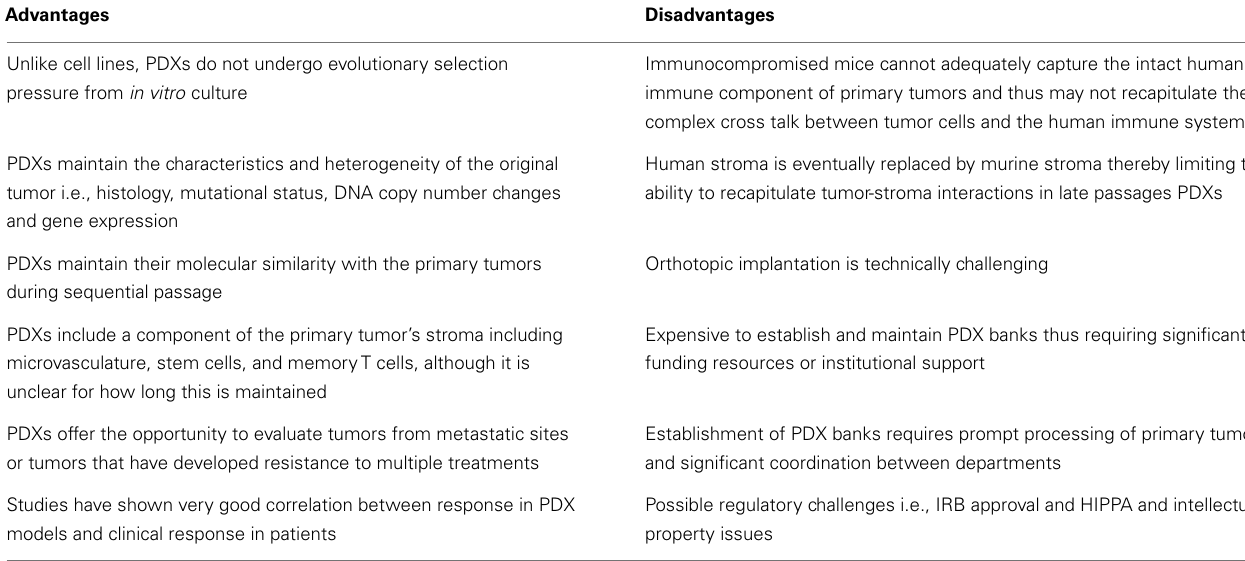
Table 2 |Advantages and disadvantages of PDX